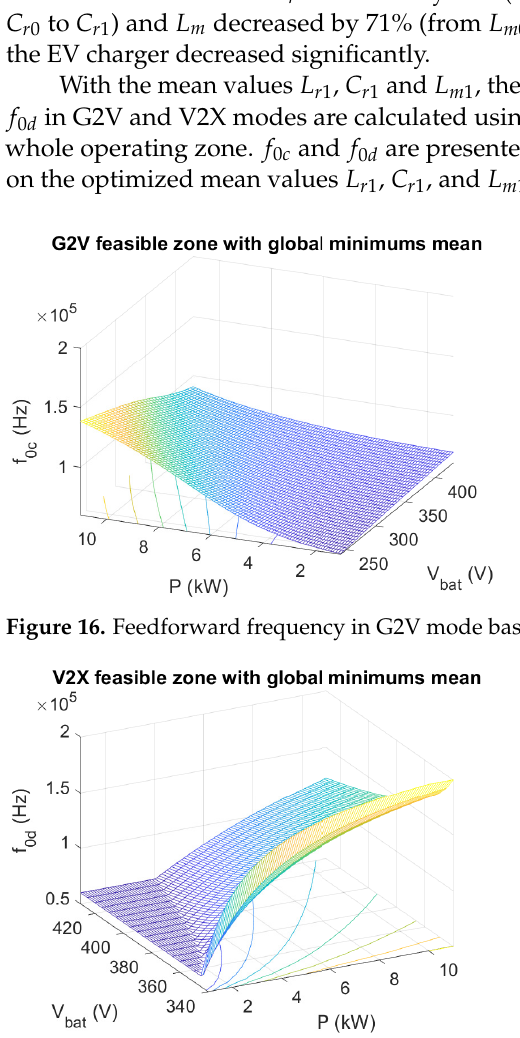
Figure 17. Feedforward frequency in V2X mode based on the optimized